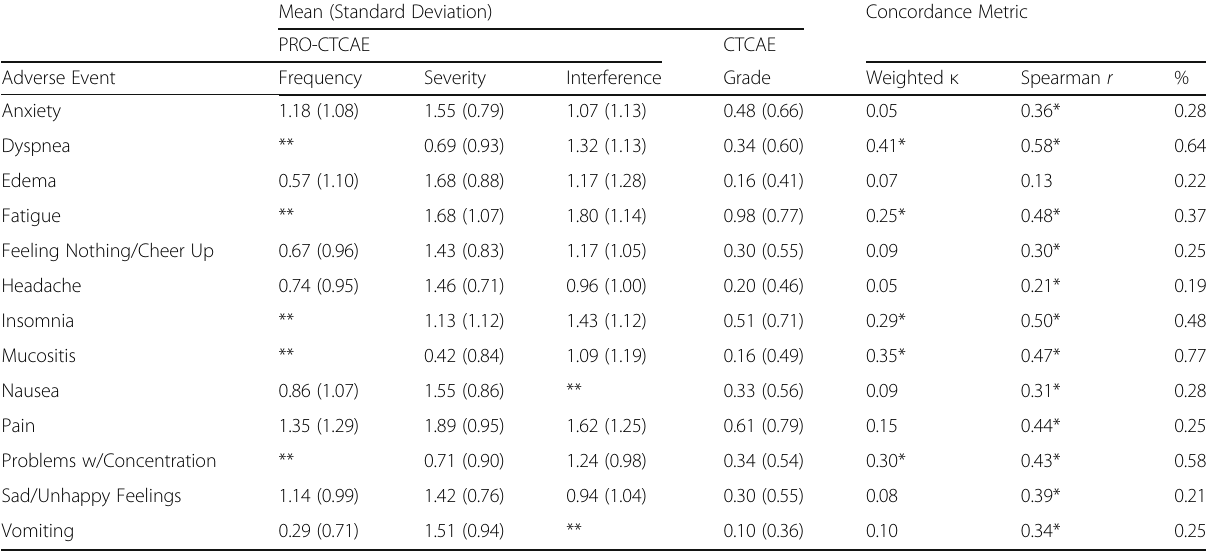
Table 5 Means, standard deviations, and traditional concordance metrics for patient adverse events Mean (Standard